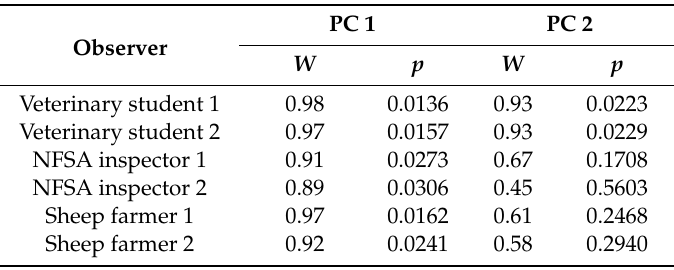
Table 4. Intra-observer agreement for individual observers given as Kendall’s coe ffi cient of concordance (W). p -values are considered significant at 0.05 level. PC = principal component, NFSA = Norwegian Food Safety